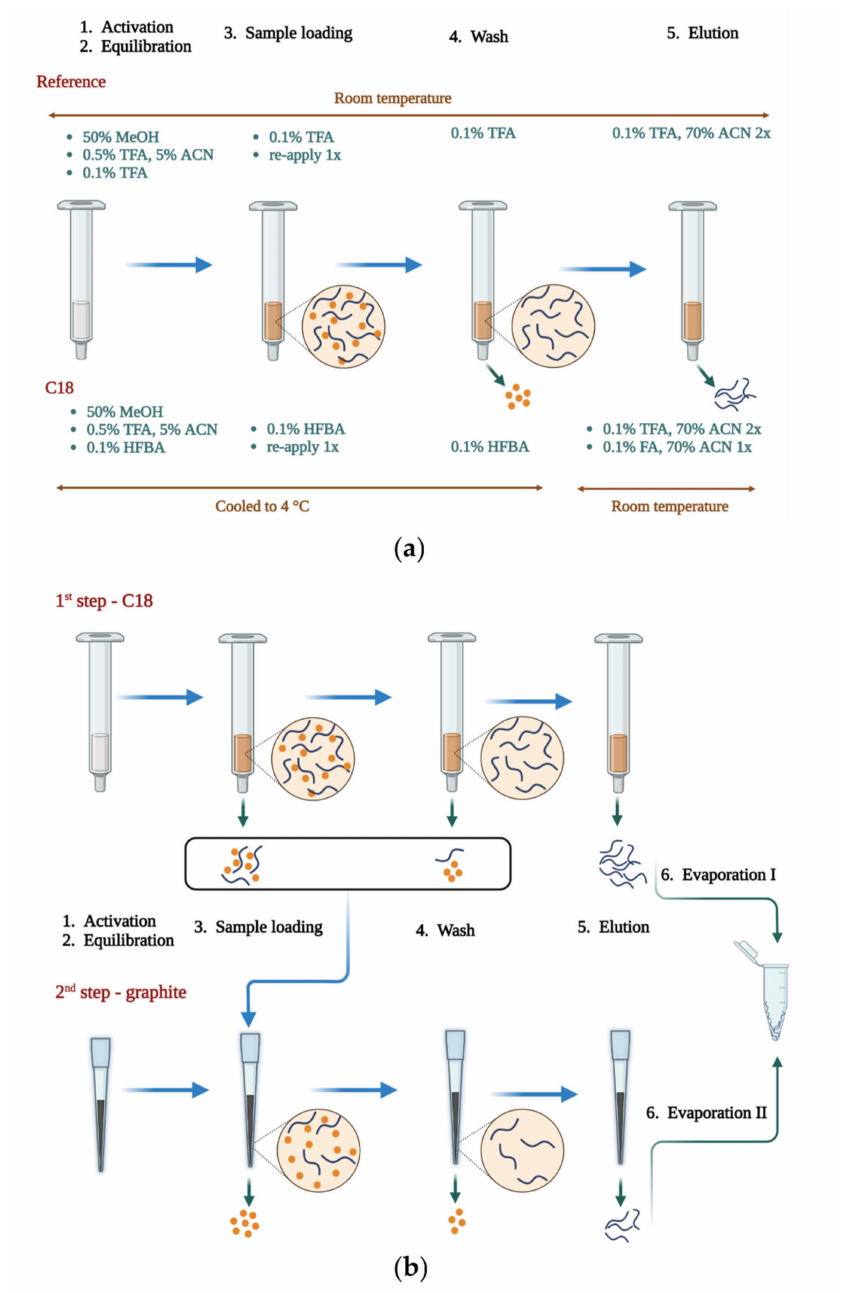
Figure 1. ( a ) Demonstration of differences between the C18 and reference methods. ( b ) Workflow for the combined C18 + graphite